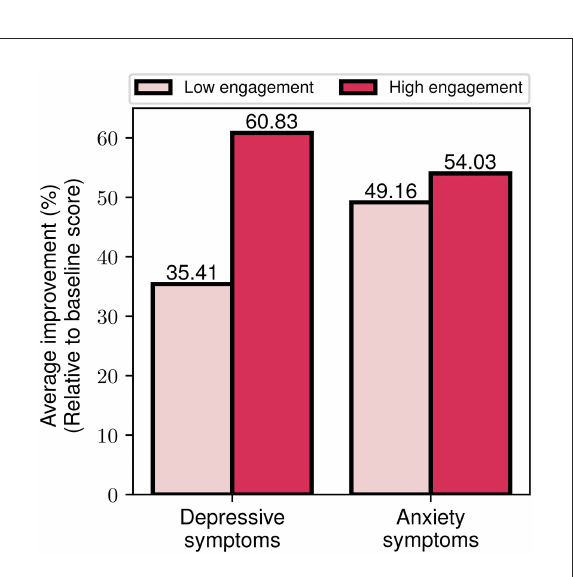
FIGURE11 Average depressive and anxiety symptom improvement for low and high engagement participant